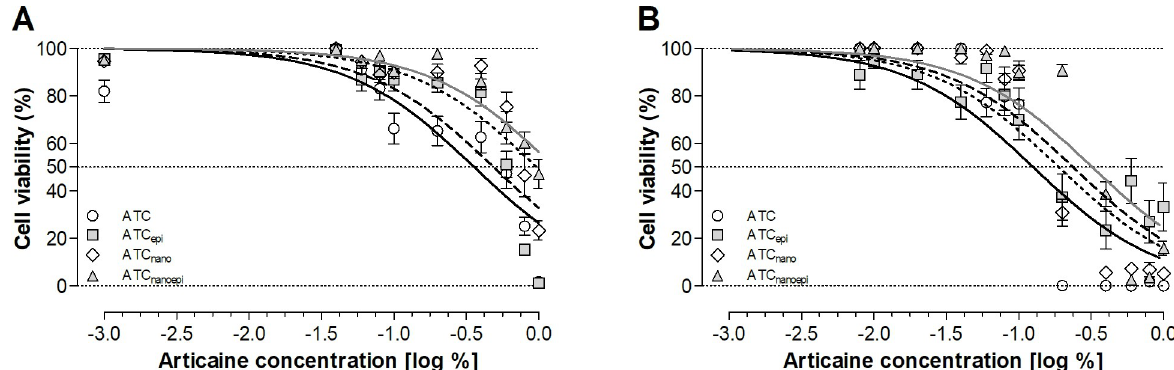
Fig 1. Percentage (%) cell viability (mean ± SEM) after (A) 1-h and (B) 24-h exposure to the formulations containing articaine at different concentrations, using the MTT colorimetric assay ATC: Articaine; ATC epi : Articaine with 1:200,000 epinephrine; ATC nano : Articaine-loaded poly